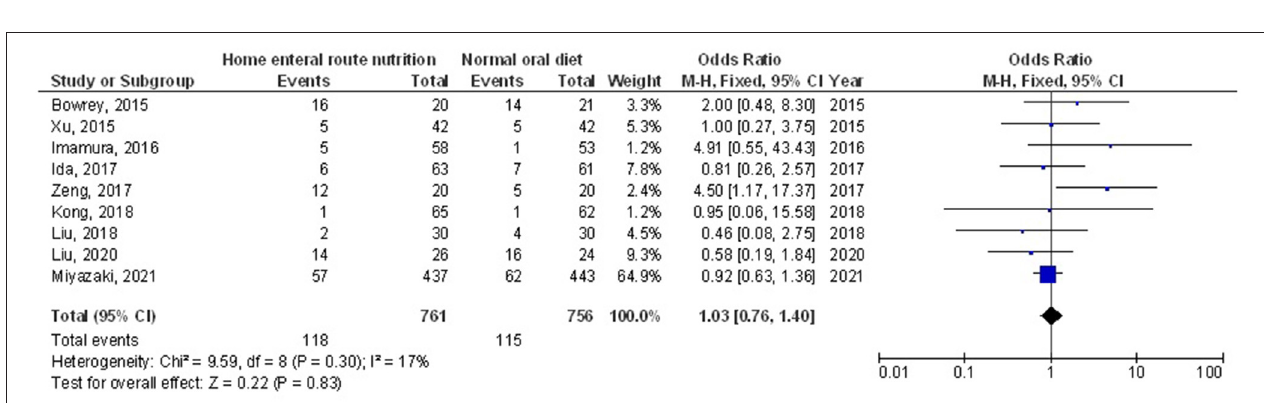
0.001) with moderate heterogeneity (I 2 = 51%), and higher